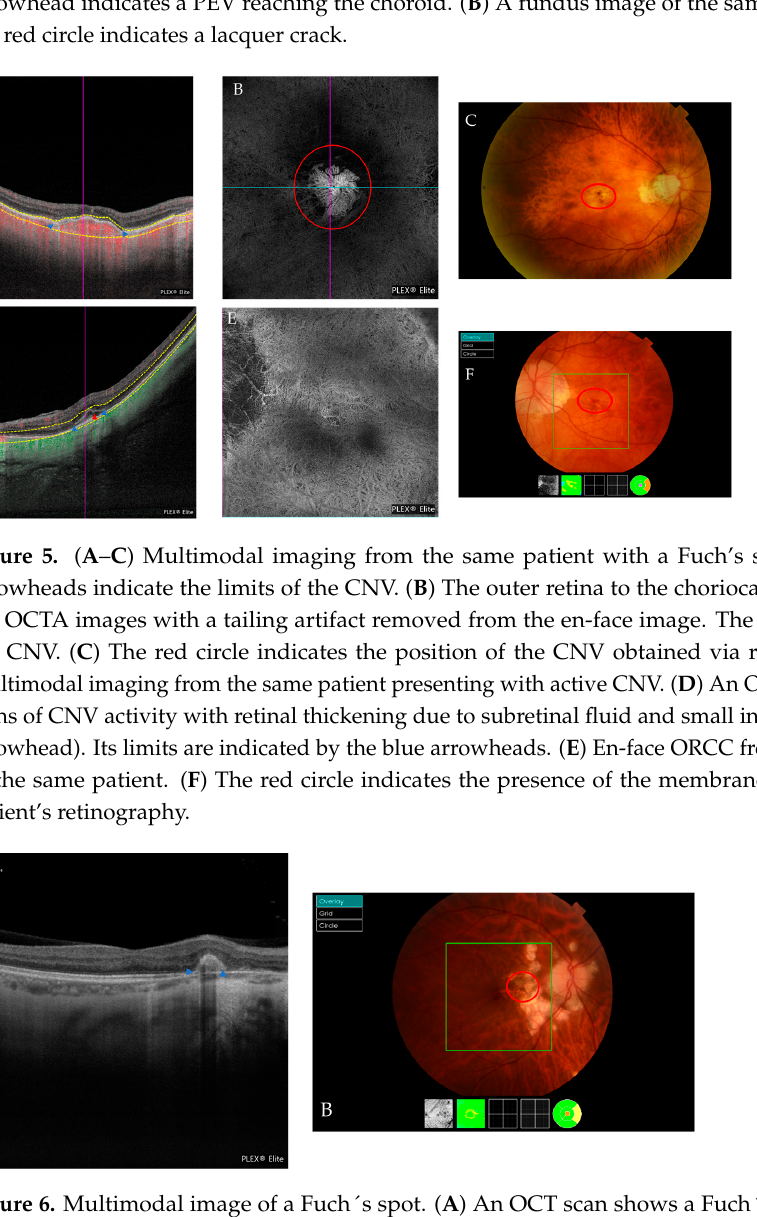
Figure 4. ( A ) An OCT scan that shows a BMD caused by a lacquer crack (blue arrowhead). The red arrowhead indicates a PEV reaching the choroid. ( B ) A fundus image of the same patient, in which the red circle indicates a lacquer crack.